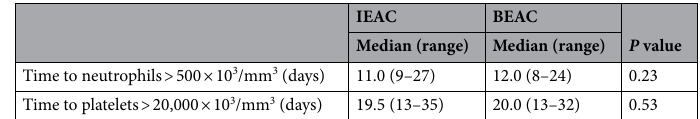
Table 2. Hematopoietic engraftment after ASCT.